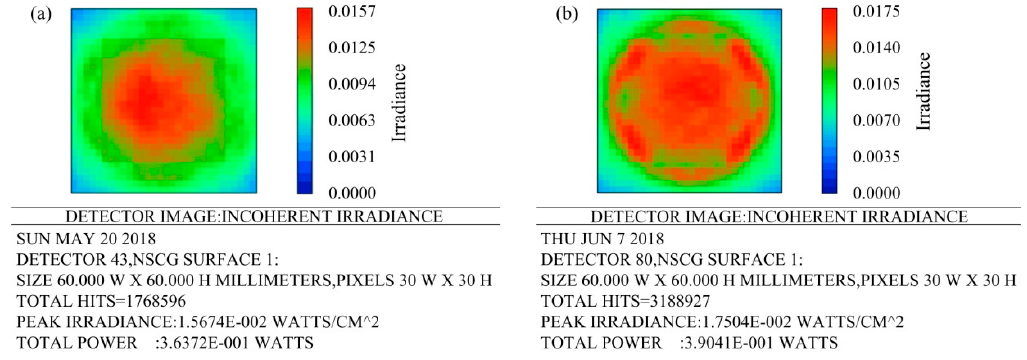
Figure 6. Light intensity distribution: ( a ) Light intensity distribution obtained by the ordinary microlens array; ( b ) Light intensity distribution obtained by the compound eye.